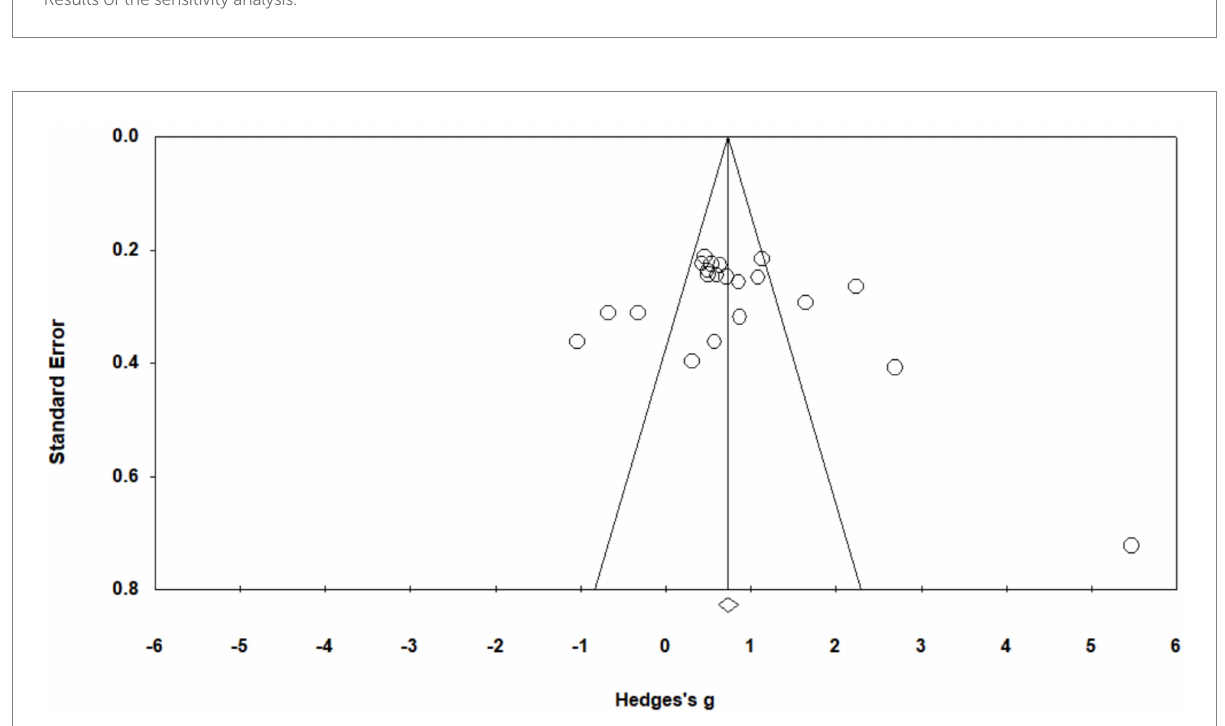
FIGURE 4 Funnel plot with effect